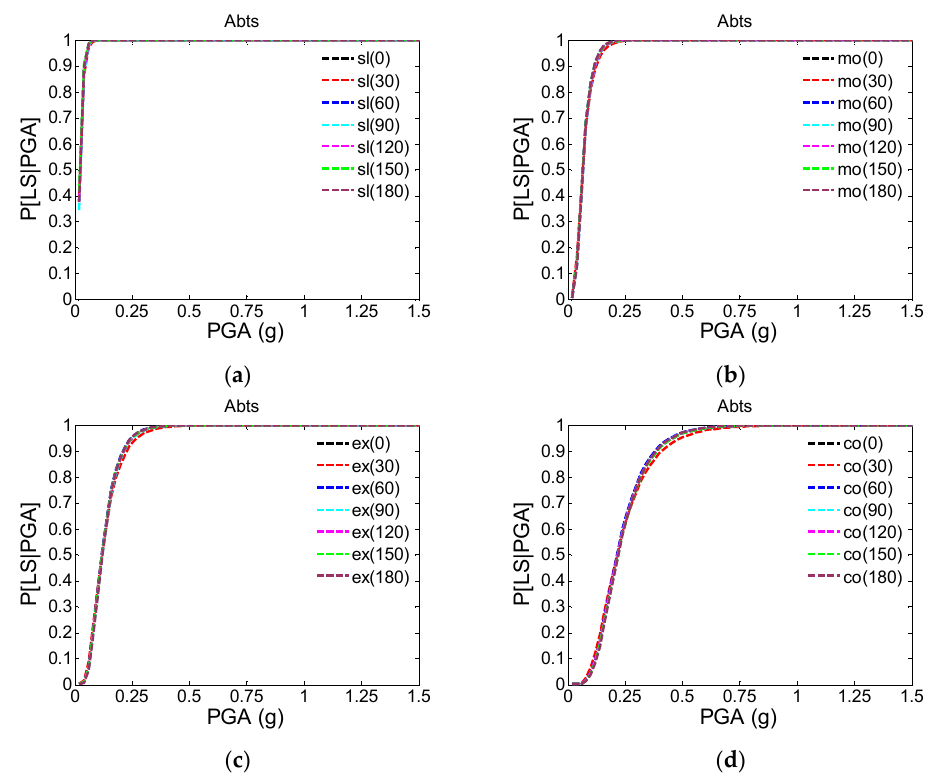
Figure 11. Seismic fragility curves of Abts subjected to different excitation angles in the ( a ) slight; ( b ) moderate; ( c ) extensive; and ( d ) complete limit states.